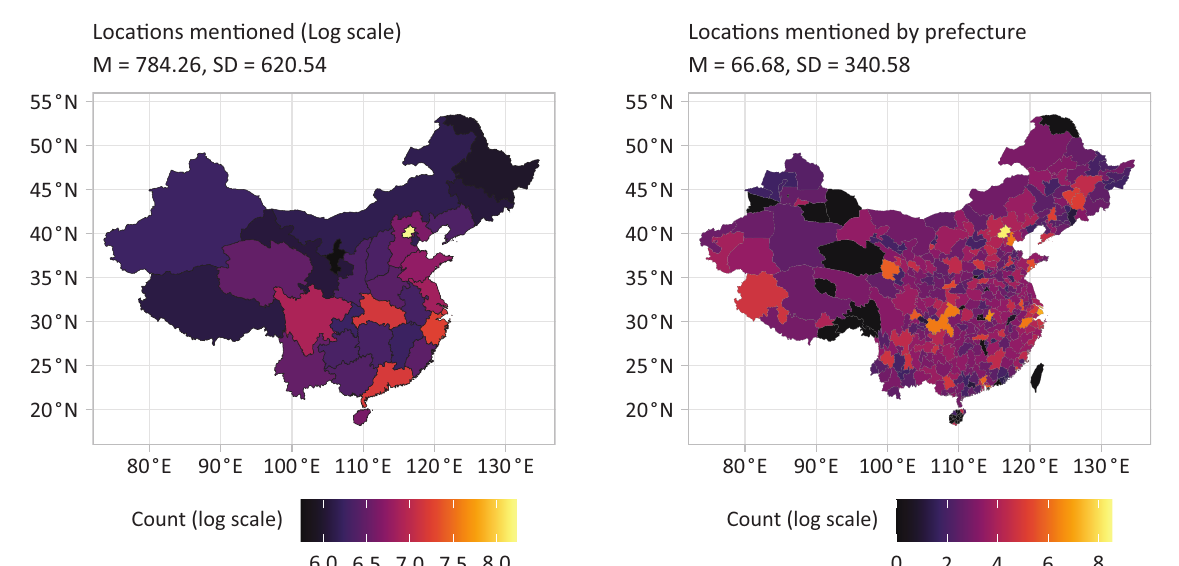
Figure 4. Locations mentioned per province and prefecture. Note: Due to highly variable count data, a natural log scale was